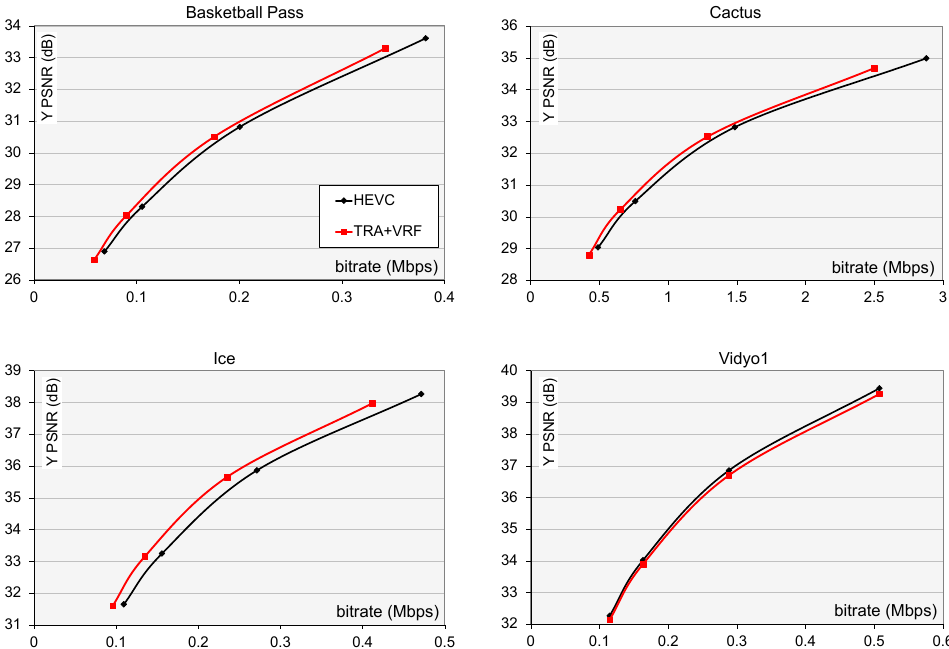
Figure 9. RD performance comparison between the original HEVC and the proposed methods for various sequences, full frames, low-rate.